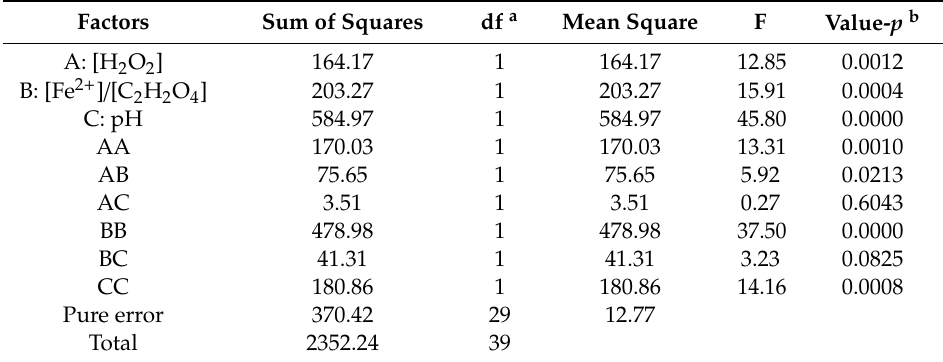
Table 8. ANOVA results for ferrioxalate-induced solar photo-Fenton experiments with leachate pre-treated with FeCl 3 · 6H 2 O